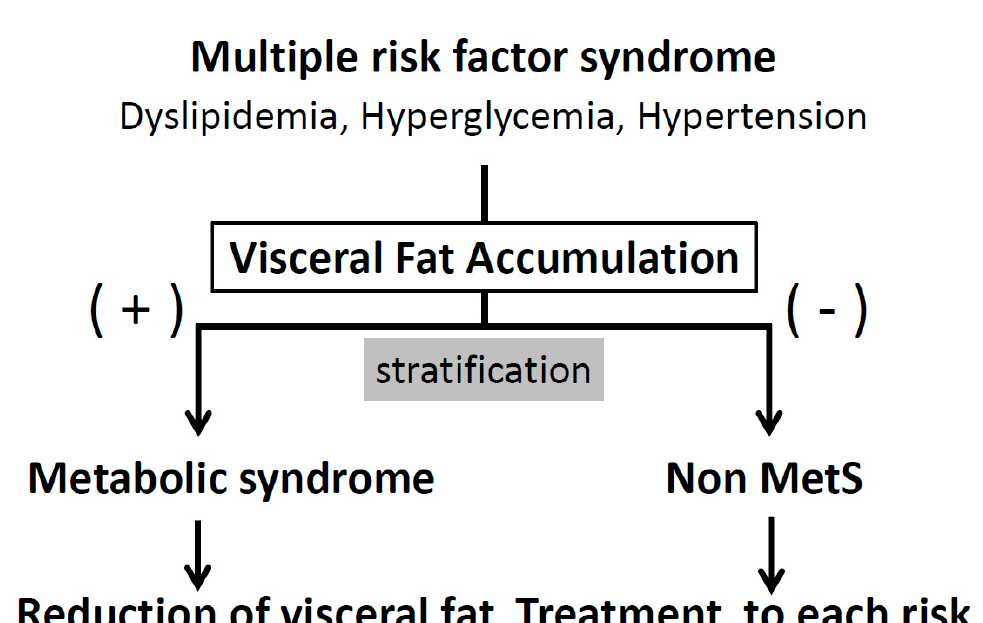
Figure 1. Concept of metabolic syndrome.